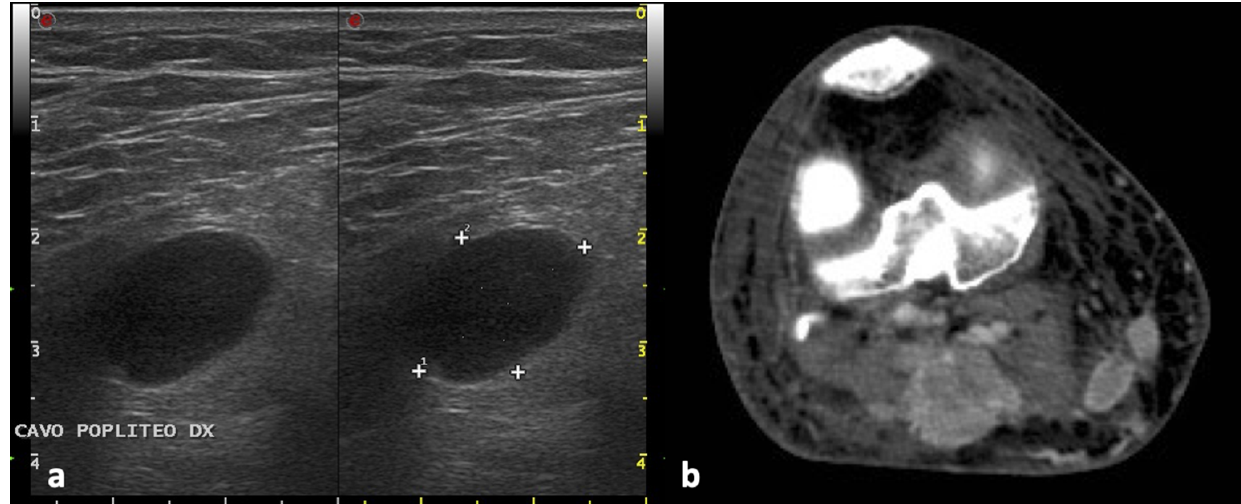
Figure 1. Lymphadenopathy of the right popliteal fossa from cutaneous melanoma of the calf. The B-Mode US scan ( a ) shows an oval, heterogeneous, predominantly hypoechoic lymph node with sharp margins. The contrast-enhanced CT axial-scan image ( b ) demonstrates a partially necrotic lymphadenopathy with peripheral enhancement.